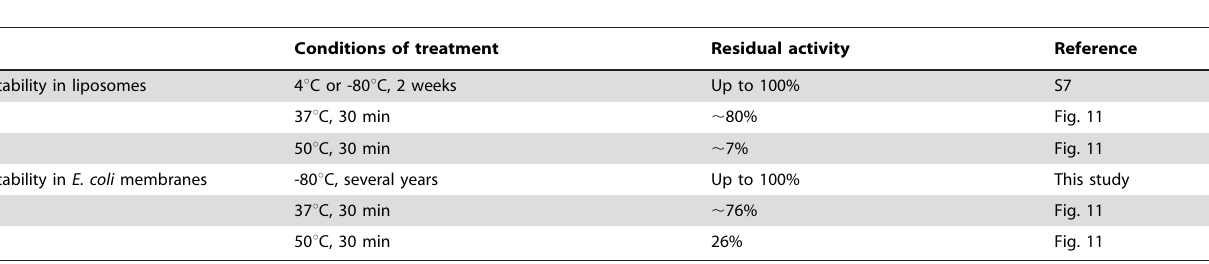
Table 4. Stability of CB 2 in liposomes and in E. coli